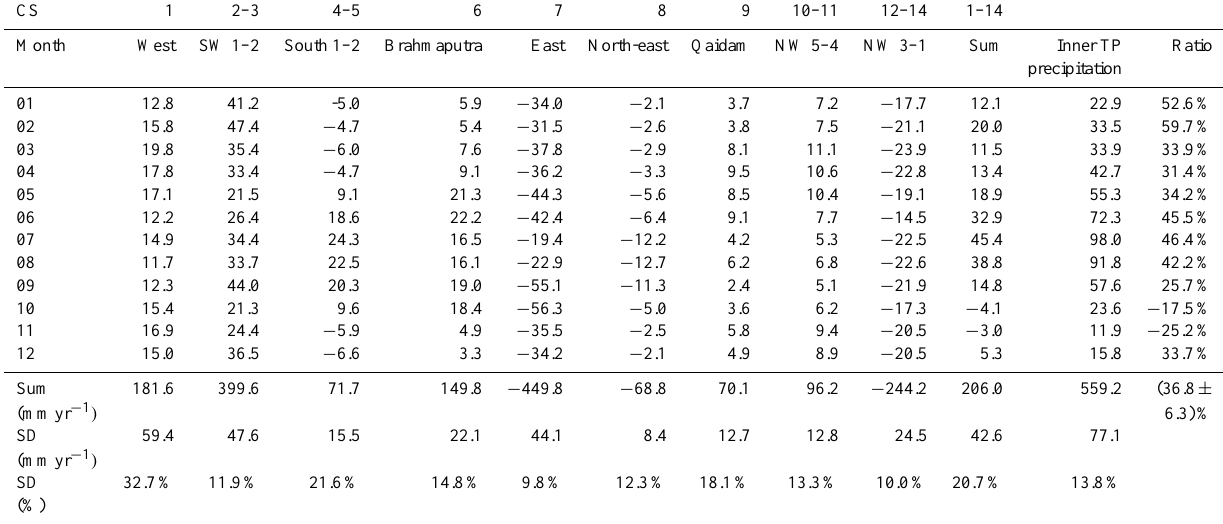
Table 1. Decadal average of the atmospheric water flux converted to a theoretical precipitation amount (mmmonth − 1 ) through vertical cross sections (1, 2–3, 4–5, 6, 7, 8, 9, 10–11, 12–14) and standard deviations (SD) for HAR10 (positive values denote transport towards the TP and negative values denote transport away from the TP). Decadal average of the precipitation (mmmonth − 1 ) and its standard deviation (SD) on the inner TP and of the contribution (%) of the atmospheric water flux to the precipitation for HAR10.